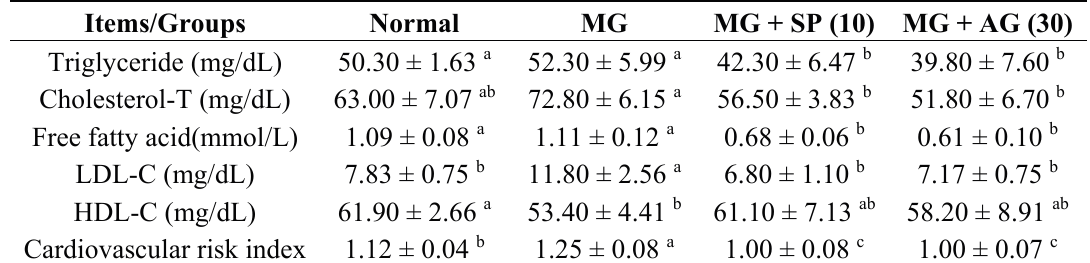
Table 1. Serum TC, LDL-C, and cardiovascular risk index. (a–c) indicate statistically significant differences p < 0.05. Data are presented as mean ± SD ( n =